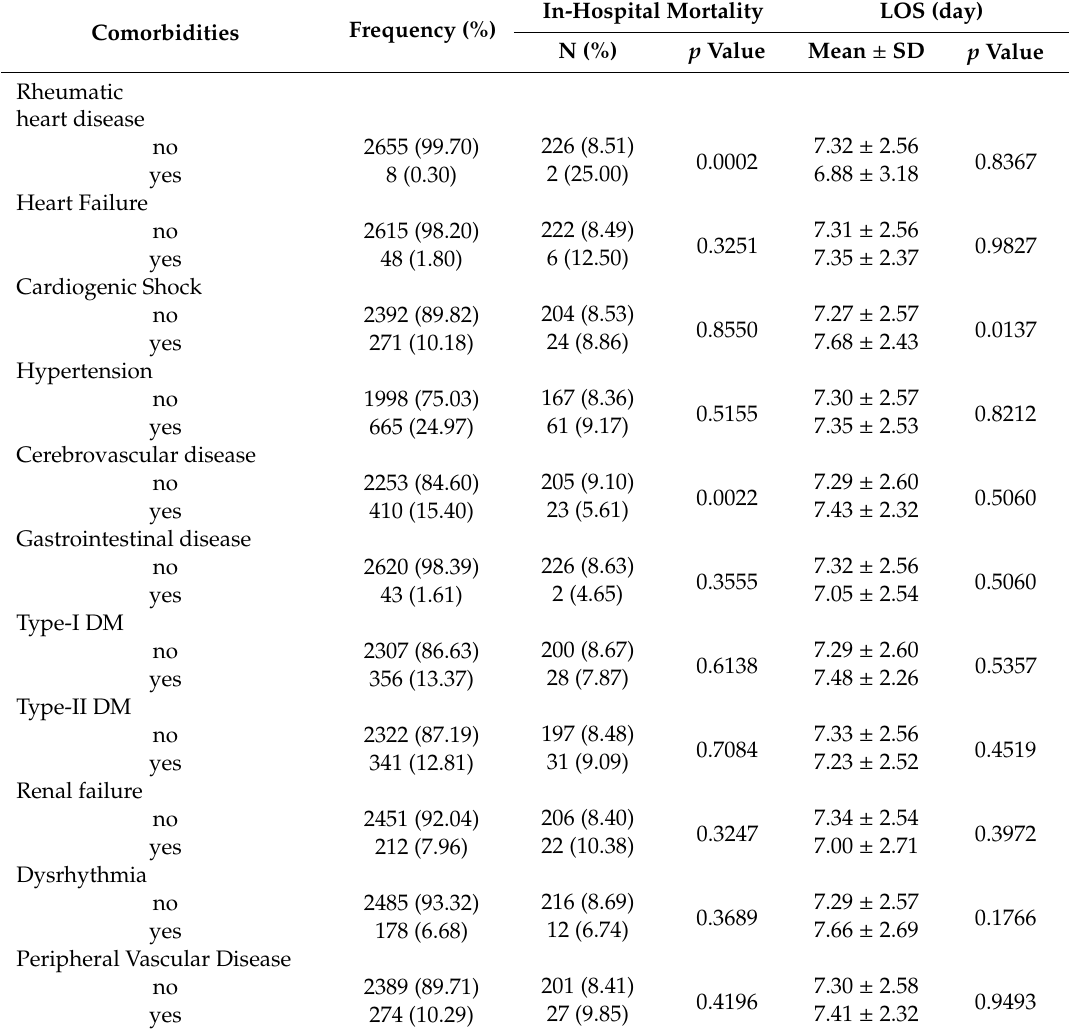
Table 2. Univariate analysis of comorbidities with in-hospital mortality and length of